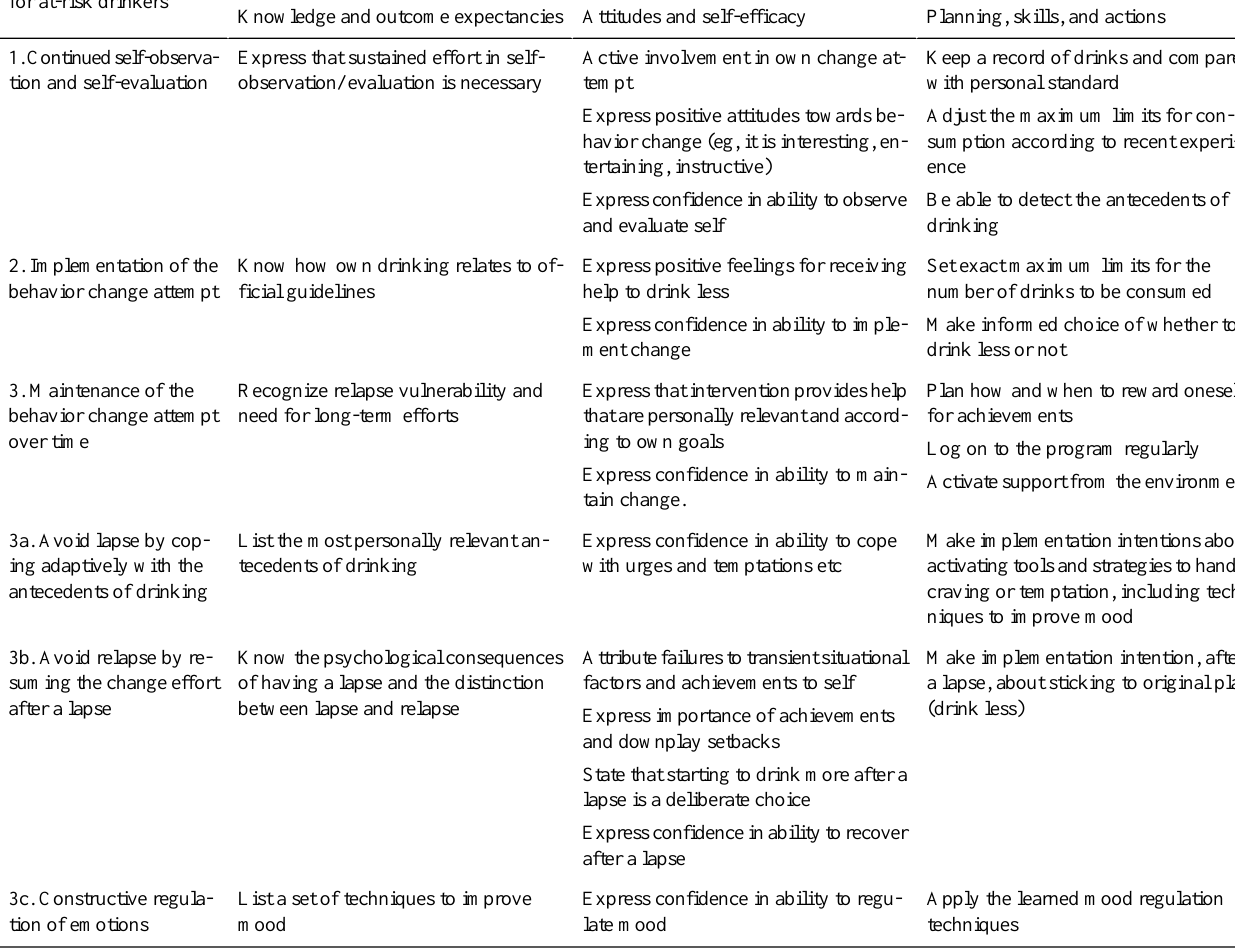
Table 1. The matrix of change objectives. DeterminantsPerformance